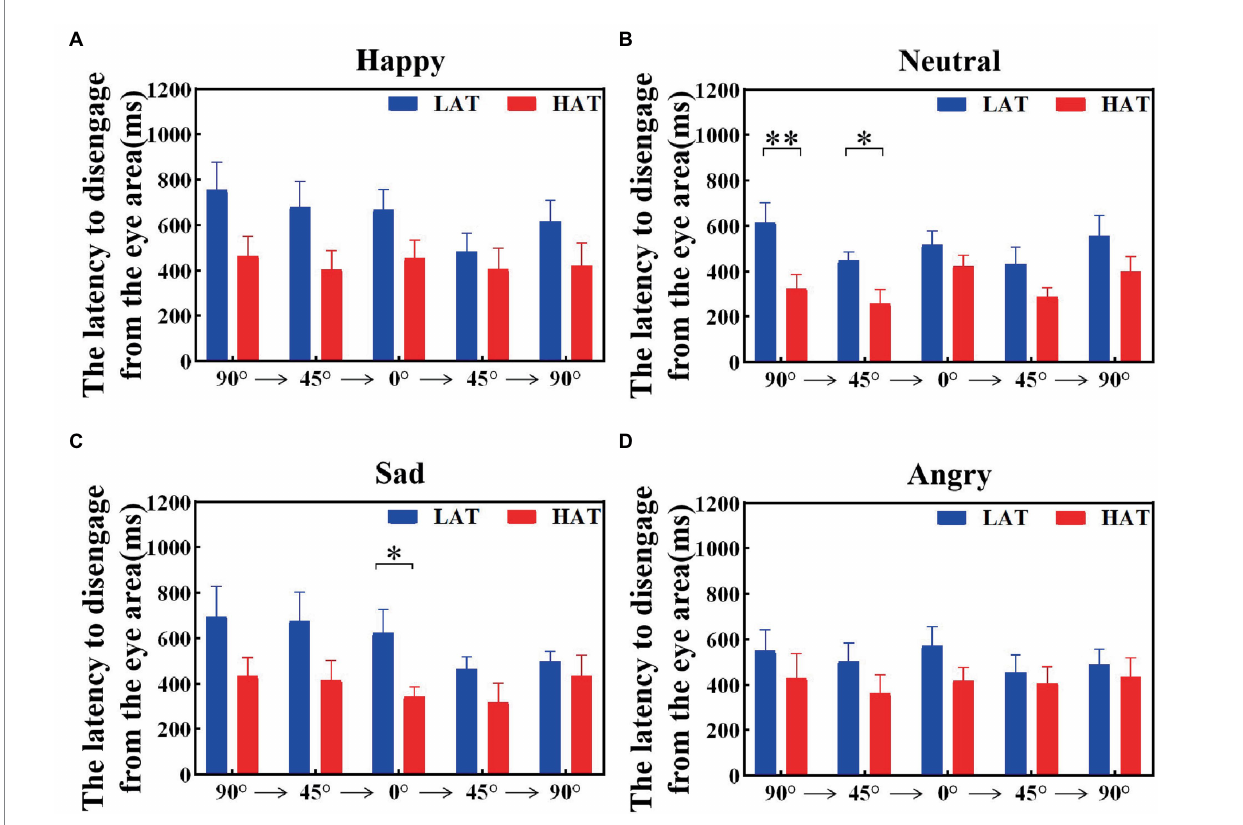
FIGURE 7 The latency to disengage from the eye area of the HAT and the LAT groups during the observation of happy (A) , neutral (B) , sad (C) , and angry (D) emotional faces with different angles in the ‘Side-Front-Side’